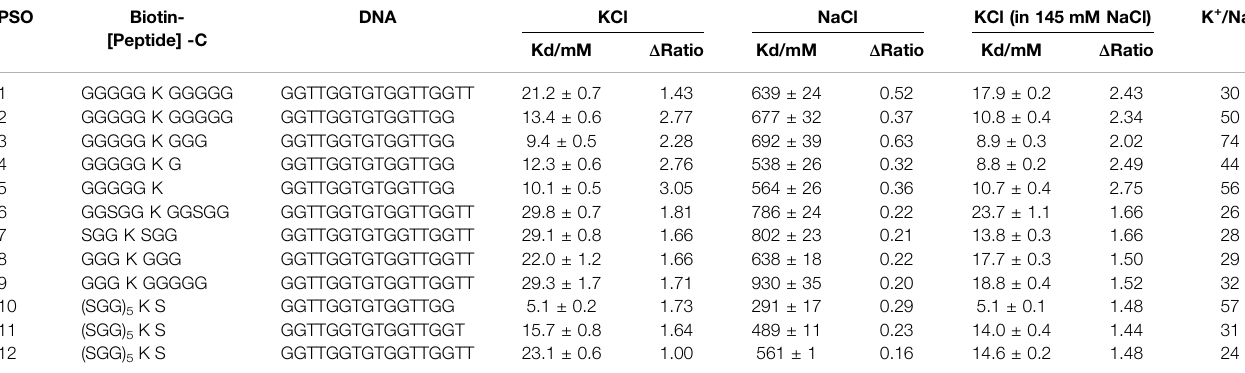
TABLE 1 | Effect of peptide and oligonucleotide portions within PSO on K + /Na + selectivity. PSO Biotin- [Peptide]